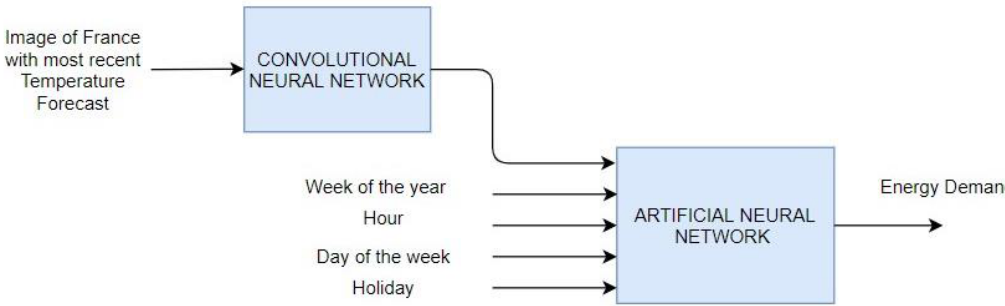
Figure 7. Deep learning structure composed of a convolutional neural network followed by an artificial neural network adapted to the energy demand forecasting problem.